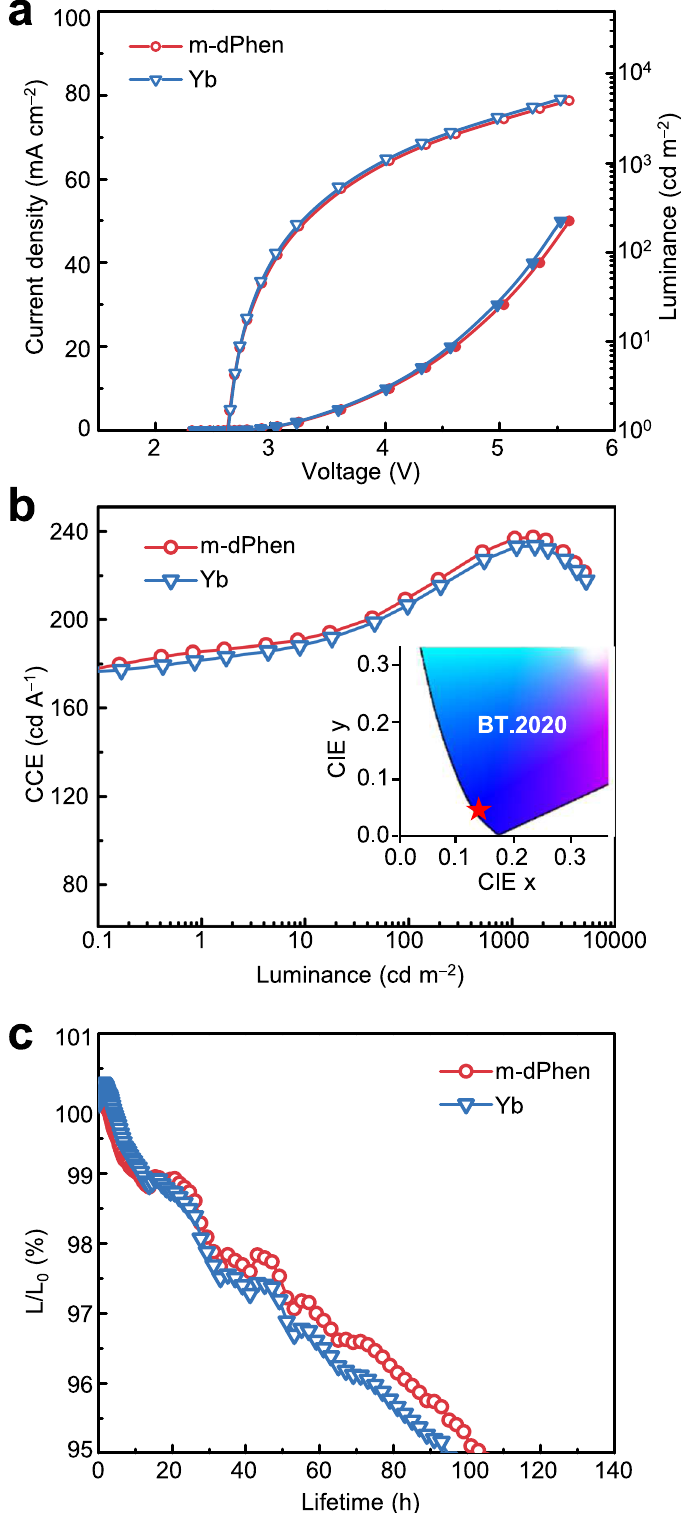
Fig. 6 Performance of top-emitting OLEDs with EILs of Yb (1 nm) and m-dPhen (1 nm). a Current density-voltage luminance ( J − V − L ) of the OLEDs using Yb and m-dPhen as EILs for comparison. b The CCE − luminance curves of the OLEDs using different EILs. c The lifetimes measured at an initial luminance of 5000cd m − 2